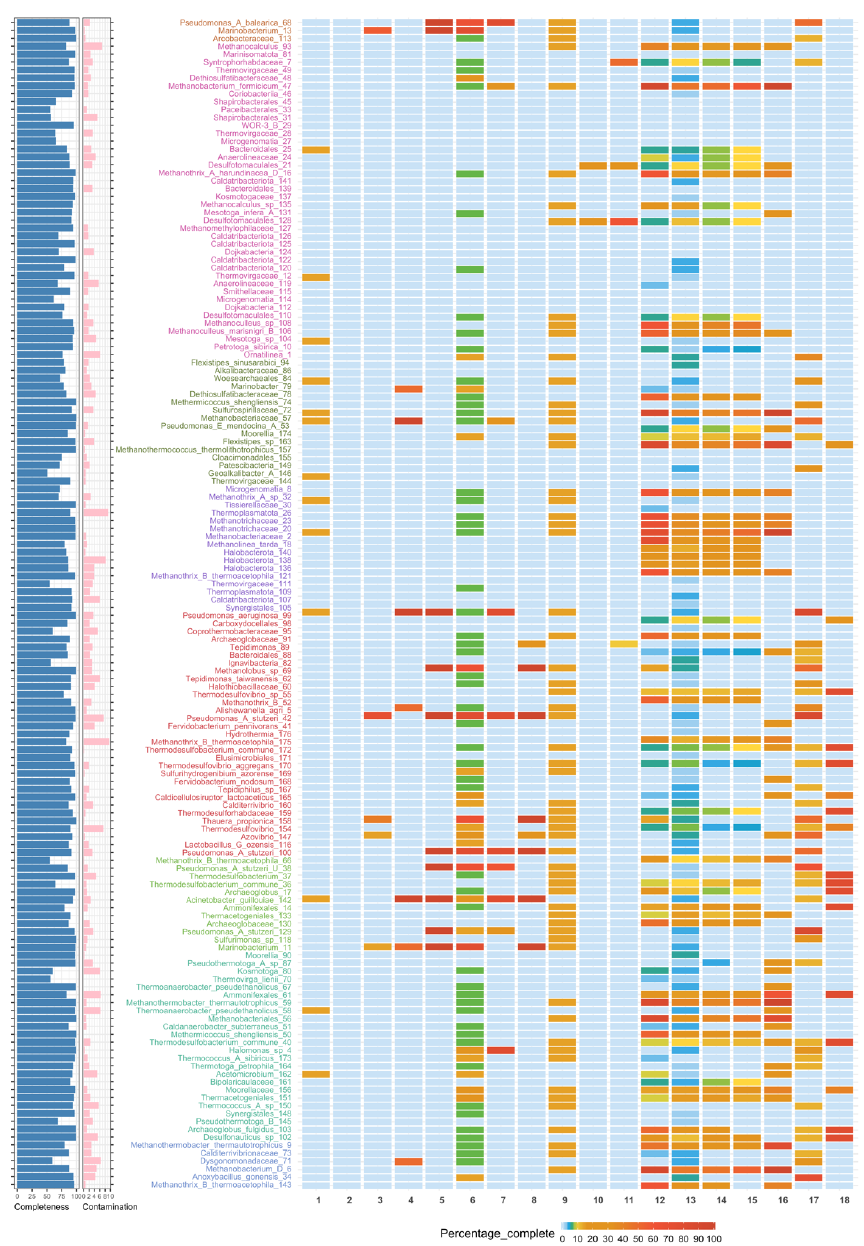
Figure 4. Heat map showing KEGG Module completeness in each MAG. Numbers below the bars: